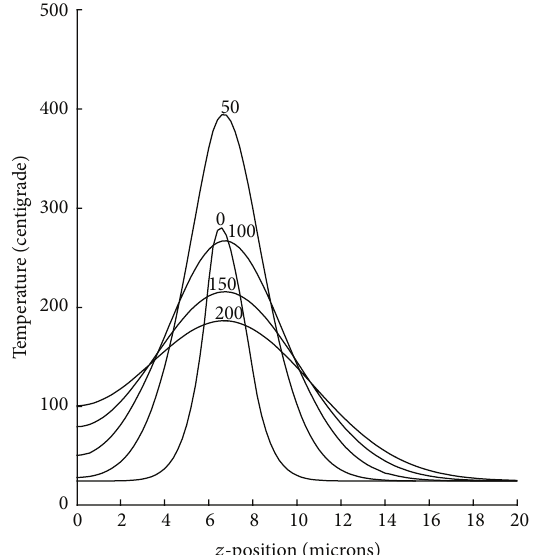
Figure 8: Temperature profiles on 𝑧 = 7 , 𝑦 = 0 , and V = 0.1 as a function of 𝑥 at times 0, 50, 100, 150, 200, and 250 𝜇